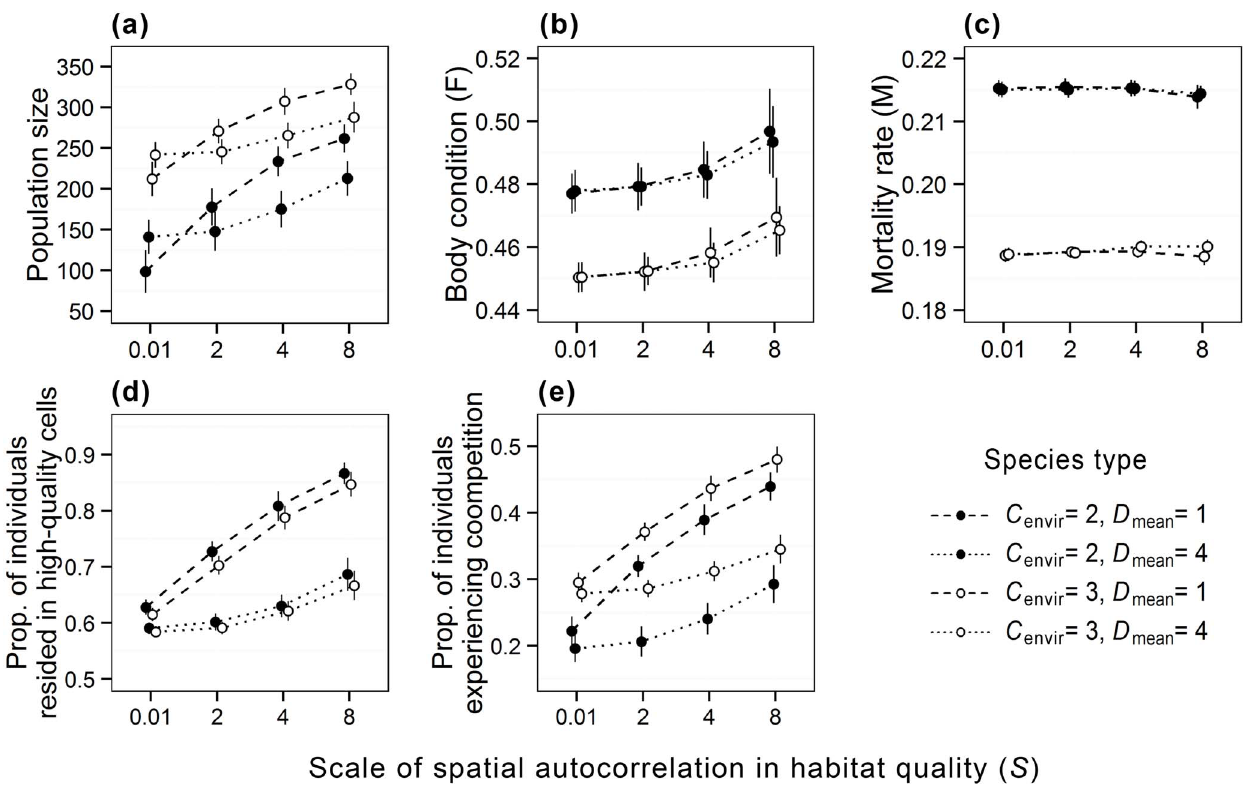
Figure 5. Population responses of four hypothetical species to the scale of spatial autocorrelation in habitat quality S . (a) population size; (b) mean resource share of individuals; (c) mean mortality rate of individuals; (d) proportion of individuals in high-quality cells ( Q $ 0.5); (e) proportion of individuals experiencing competition. The figure shows mean 6 1 SD for 50 replicates for each variable.